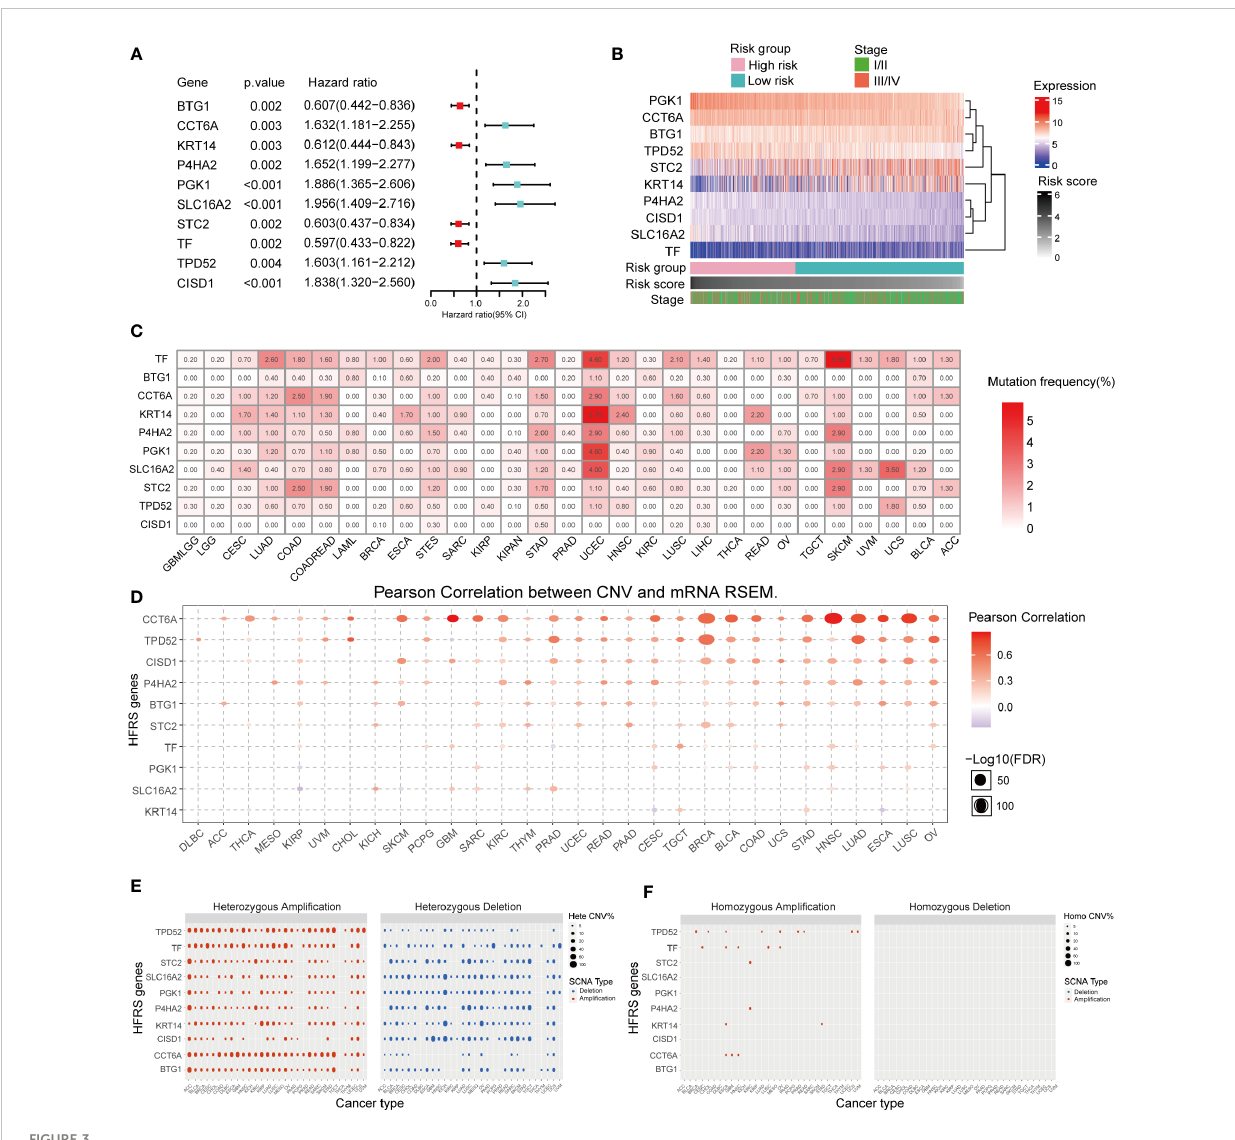
FIGURE 3 Prognosis value and expression of HFRS hub genes. (A) Forest plot shows the prognostic value of 10 prognostic genes in signature. (B) Heat map shows the relationship between mRNA expression levels of 10 HFRS genes, HFRS score, and tumor stage features in the TCGA cohort. (C) The mutation frequencies of 10 HFRS genes in pan-cancer. (D) The correlation between CNV and mRNA expression of HFRS genes in pan-cancer using Pearson analysis. The size of bubble indicated the -log10 (FDR) value. (E, F) The pro fi les of heterozygous (E) and homozygous (F) ampli fi cation/ deletion of 10 HFRS genes in